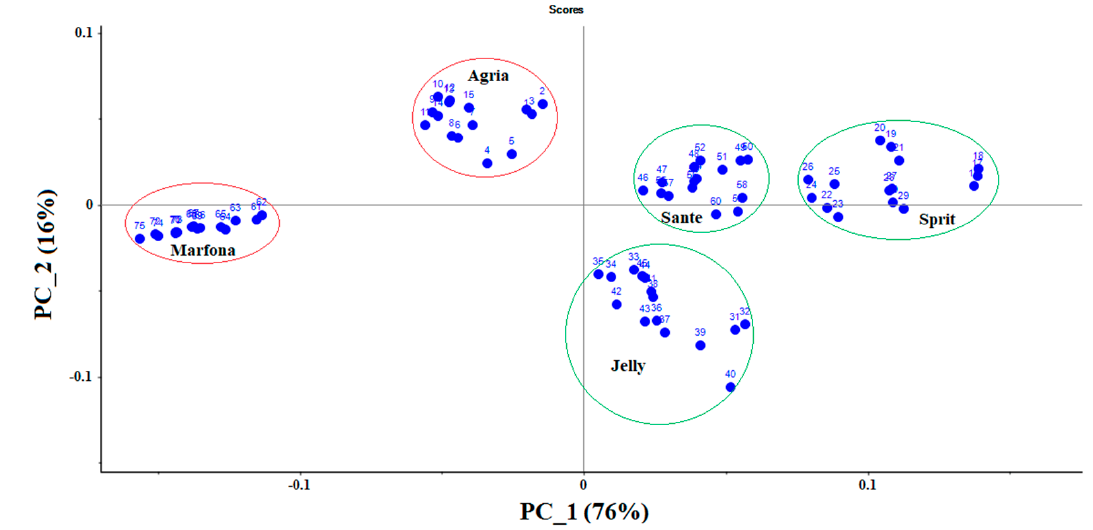
Figure 5. Two-dimensional PCA plot to identify five different potato cultivars with data collected using an electronic nose.